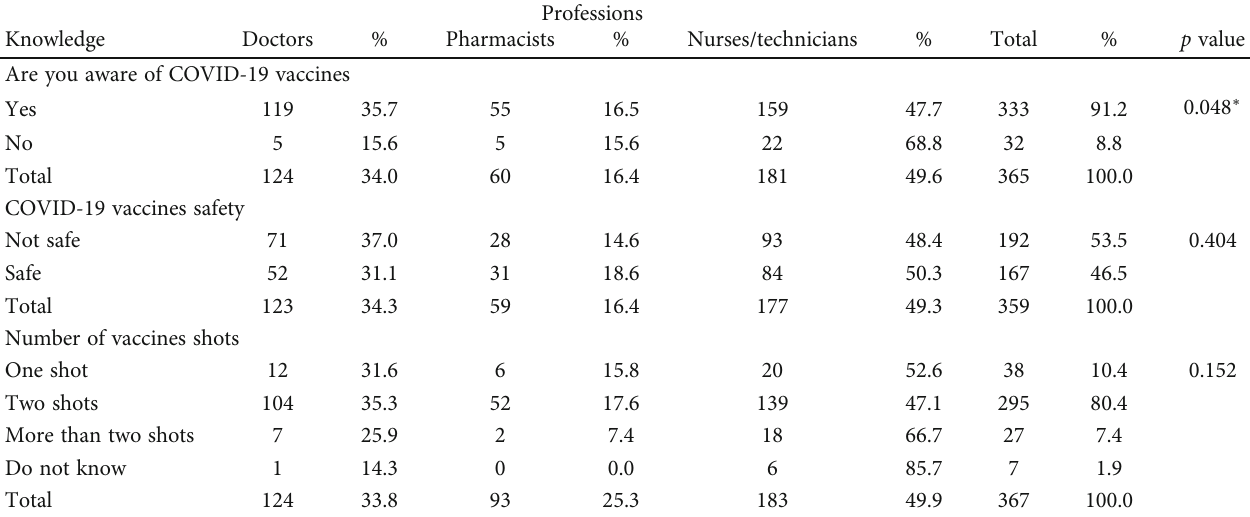
Table 2: Assessment of knowledge of participants about COVID-19 vaccination based on their